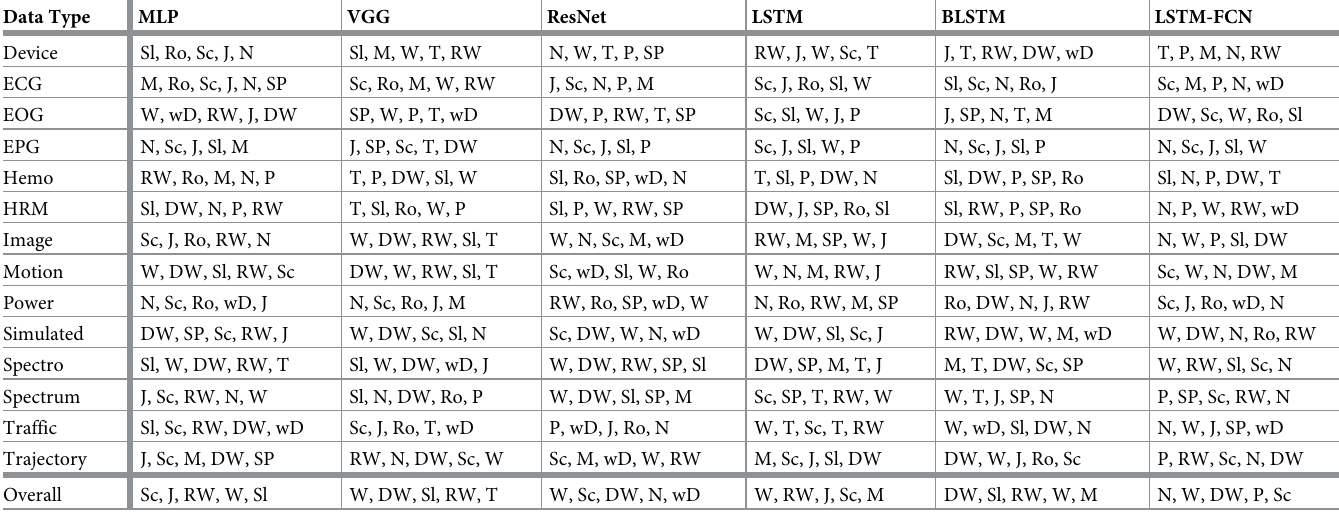
Table 5. Data augmentation recommendations for data type and model